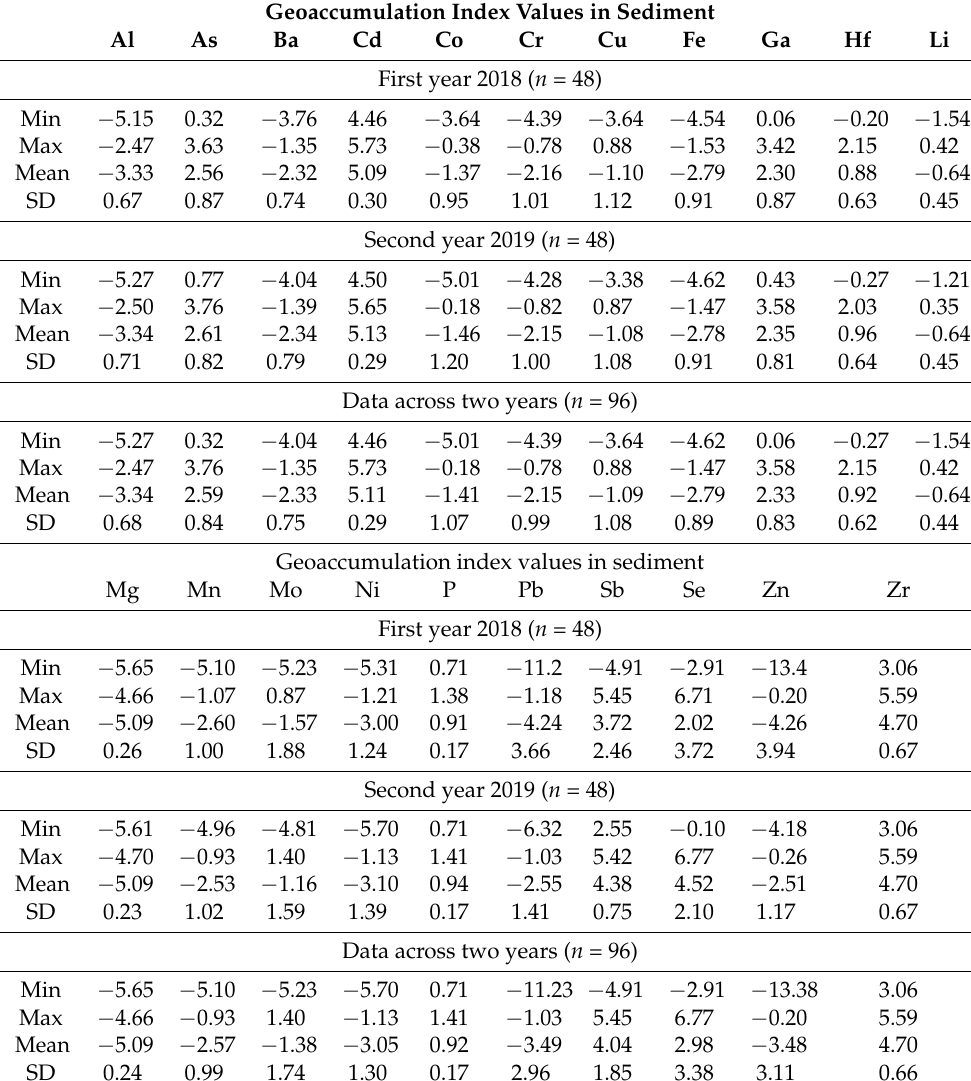
Table 5. Statistical description of Geoaccumulation index (I geo ) in Qaroun Lake sediment over two